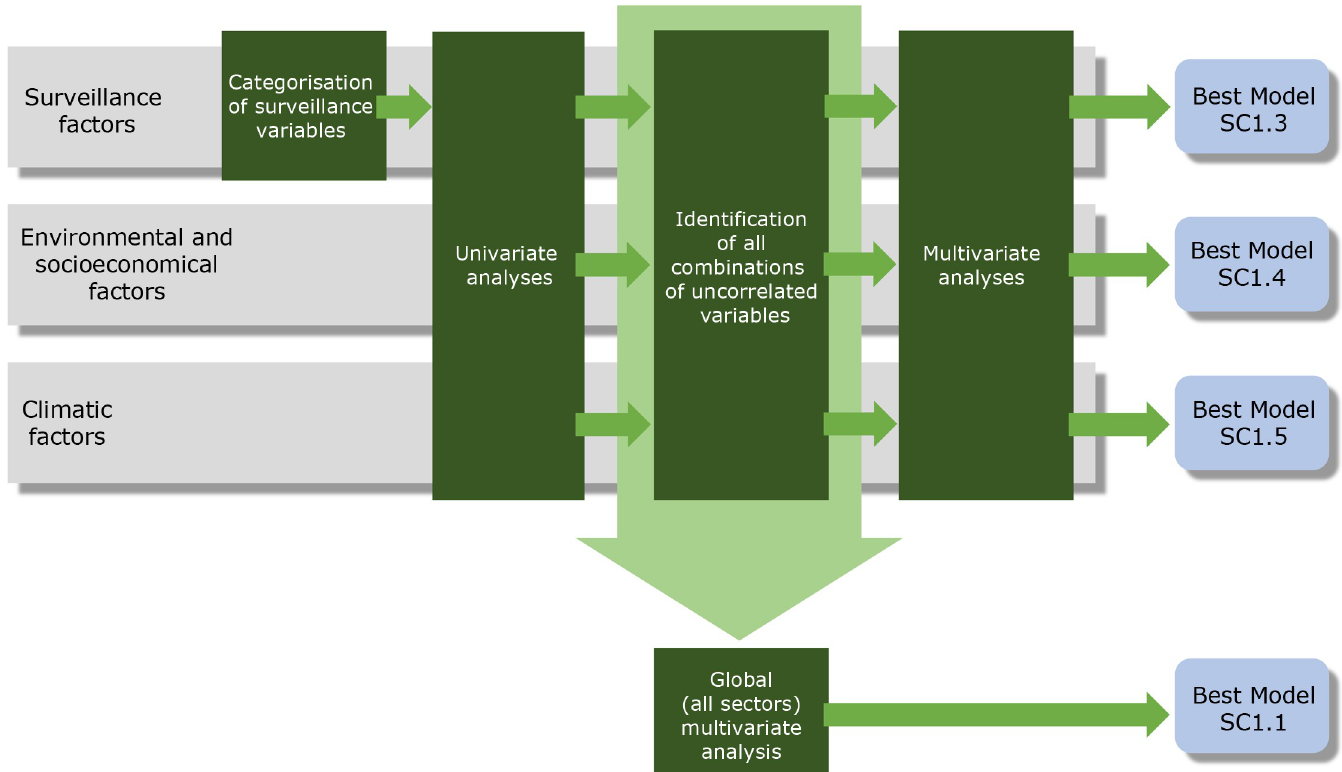
Fig 2. General outline of the analysis